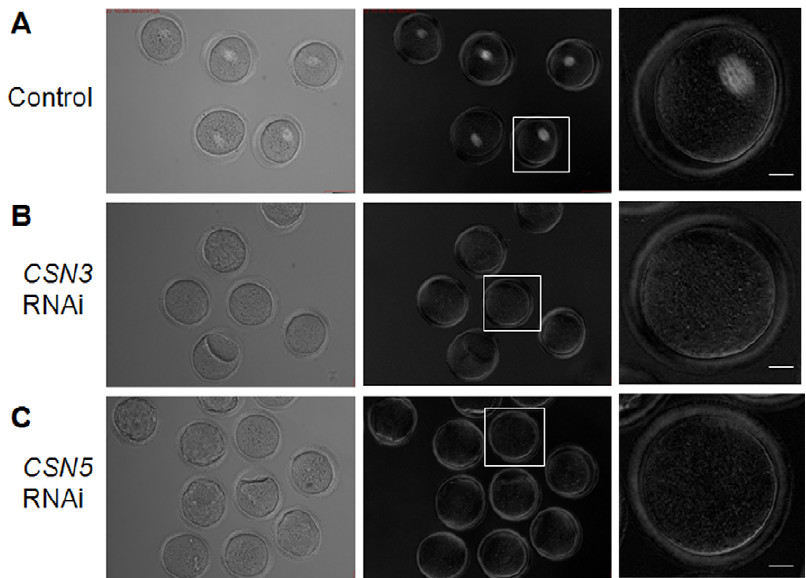
Figure 4. Down-regulation of CSN3 or CSN5 caused meiotic spindle disassembly. Spindle structure was observed noninvasively using Polscope microscopy. (A) Control MI oocytes cultured for 8 h showed normal barrel-shaped spindles. (B, C) After RNAi treatment followed by 16 h culture, oocytes were arrested at the MI stage and showed no spindle structure. Left panel, bright field; middle panels, dark field; right panels, magnified view of boxed area from the middle panels. Original magnifications 6 200 (Left and middle panels). Bar s=20 m m.